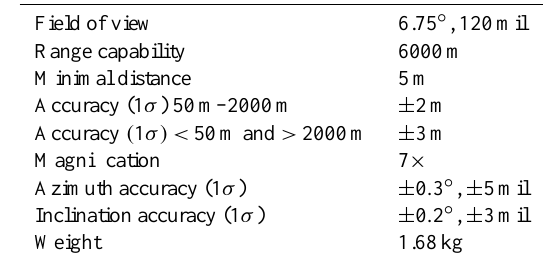
Table 1. Main technical data for the Vectronix VECTOR IV rangefinder binocular. One mil is equal to 1/6400 of 360 ◦ . Source: Vectronix AG